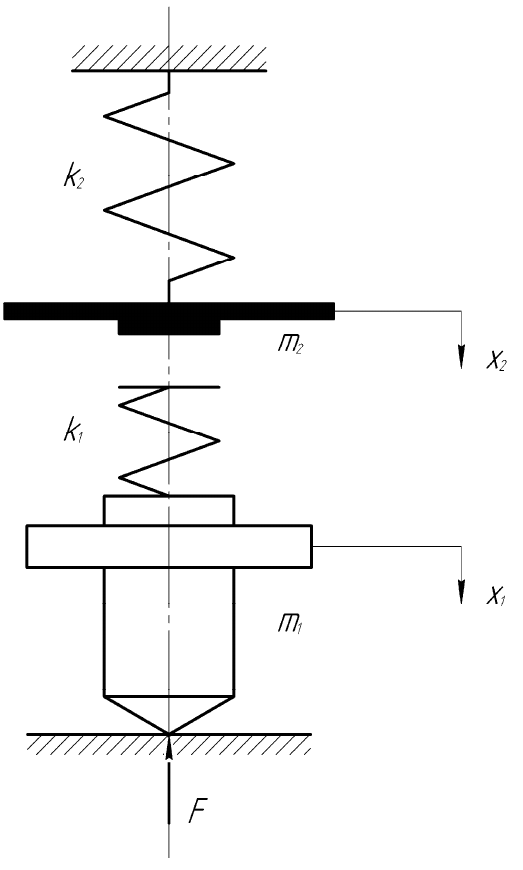
Figure 1. Scheme of the device for impact cone indentation.